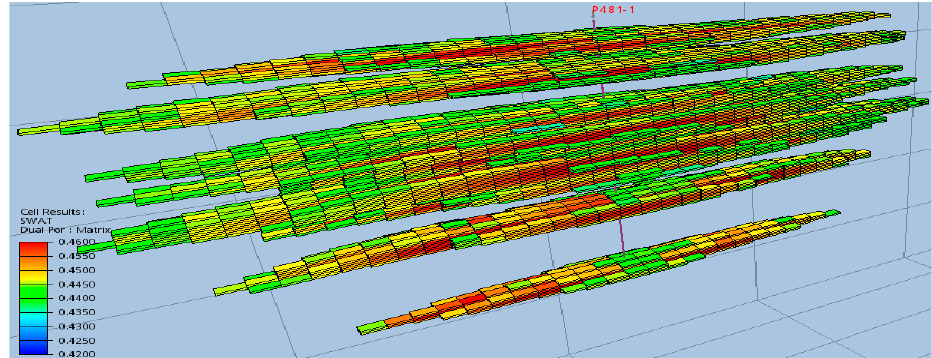
Figure 26. Fracture evolution after fracturing.